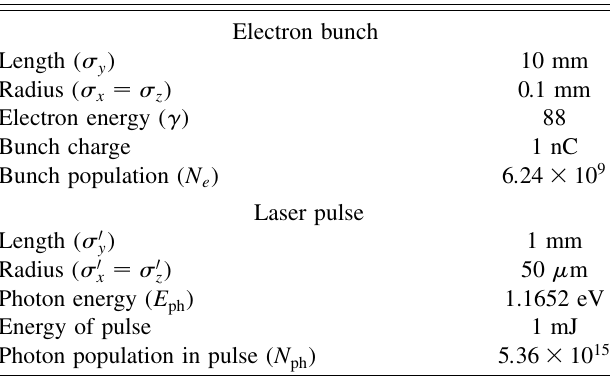
TABLE I. Parameters of colliding